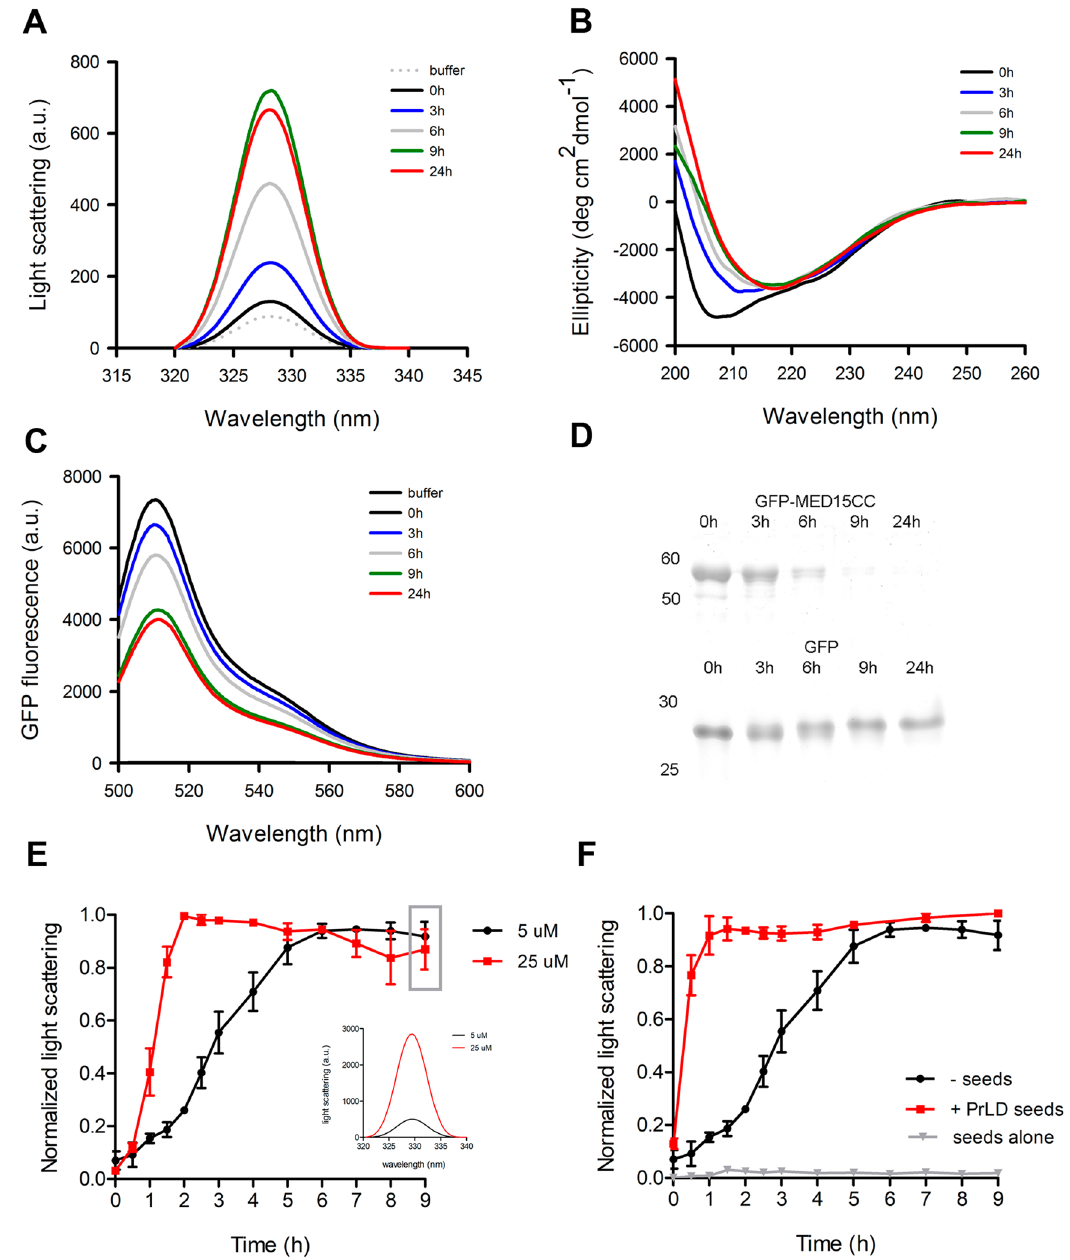
Fig. 4 MED15-PrLD aggregation kinetics characterization. A Light scattering, B circular dichroism, and C GFP fl uorescence (supernatant fraction) of 5 μ M GFP-MED15CC incubated at 37 °C at the indicated time points. D 12% SDS-PAGE of 5 μ M GFP and GFP-MED15CC supernatant fraction after centrifugation at the indicated time points of incubation. E Light scattering kinetics of 5 and 25 μ M GFP-MED15CC at 37 °C. The inlet shows the real scattering intensities at the fi nal time point (9 h, gray rectangle). F Light scattering kinetics of 5 μ M GFP-MED15CC incubated at 37 °C in the absence or presence of 2% GFP-MED15CC seeds. Kinetics of seeds alone is shown as control. All assays are performed in 20 mM Tris pH 7.5 and 150 mM